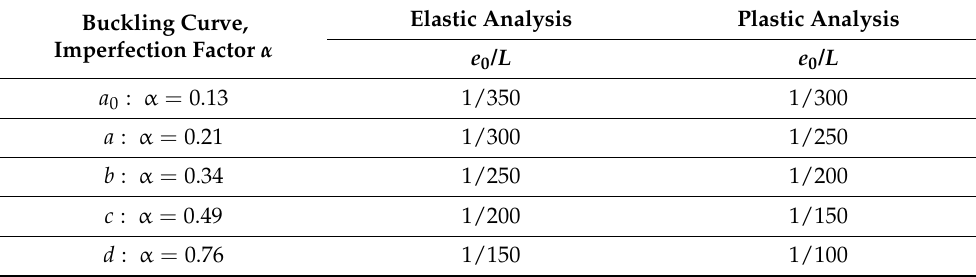
Table 7. Reference relative bow imperfection 𝛽 according to 7.3.3.1 in [18]. Buckling about Axis